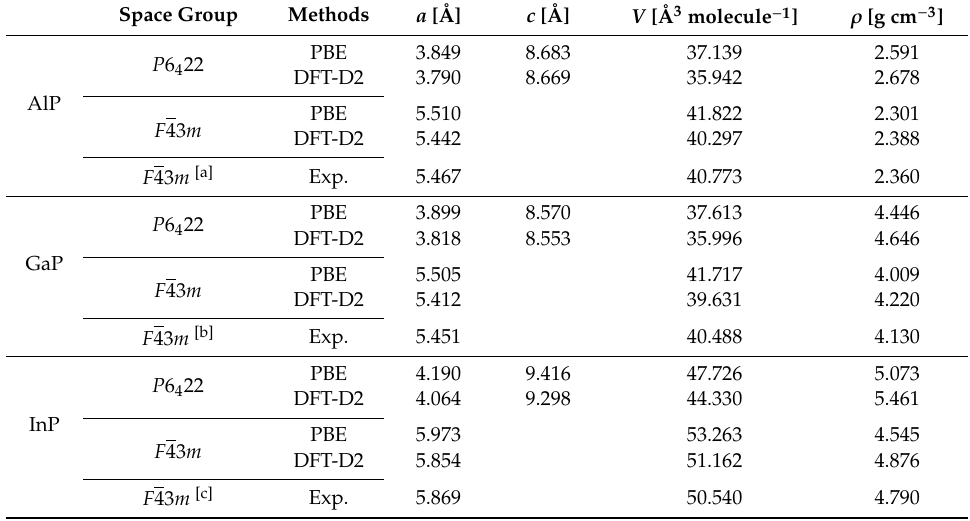
Table 1. The calculated (GGA-PBE and DFT-D2) lattice parameters and densities of P 6 4 22- and F 43 m - X P ( X = Al, Ga, or